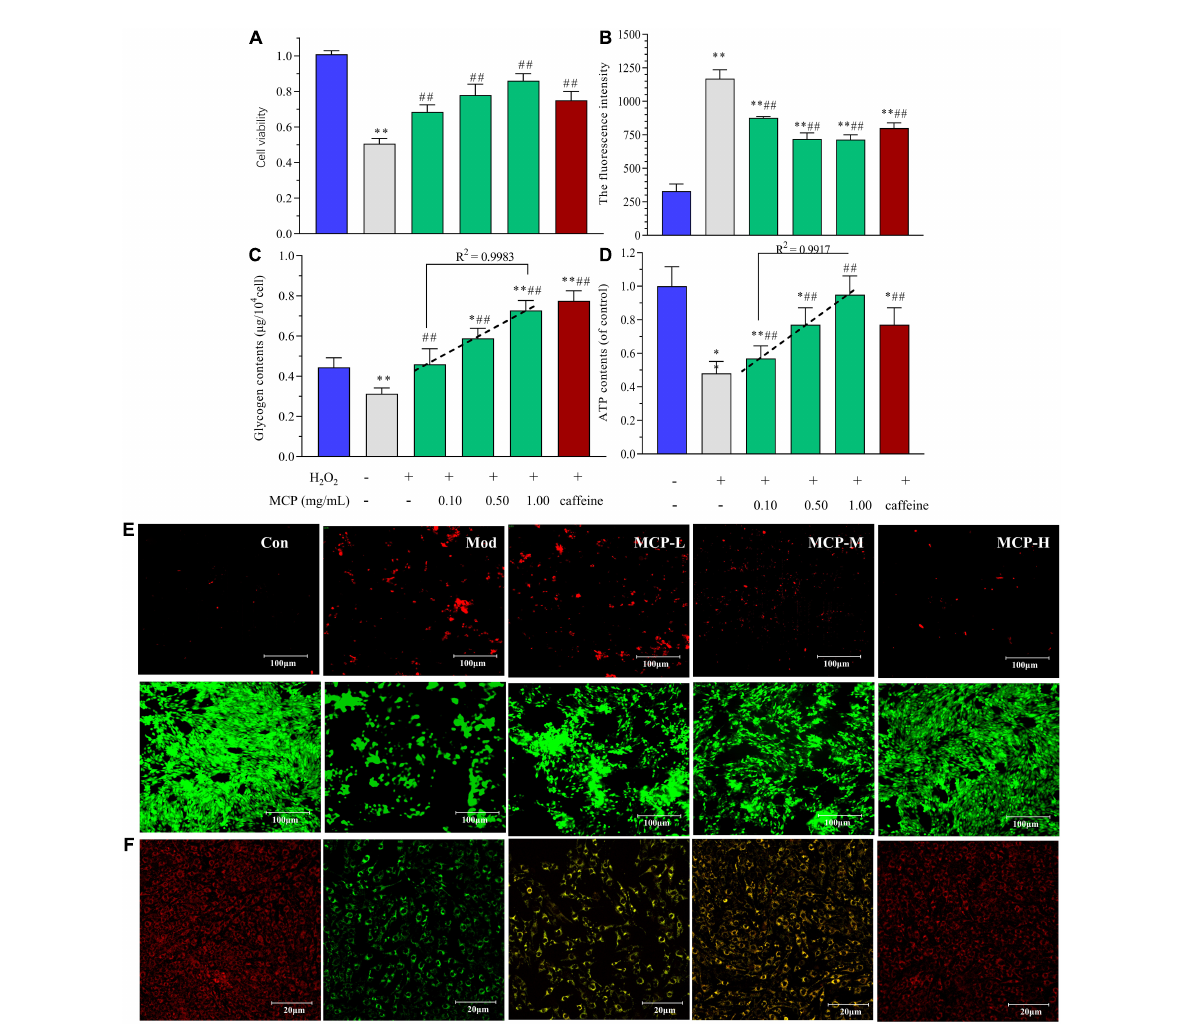
FIGURE6 Effects of Maca compound preparation (MCP) on H 2 O 2 -induced C2C12 cells. (A) Cell viability of MCP on oxidative stress-induced C2C12 cells. (B) ROS accumulation analyzed by flow cytometry. (C) Glycogen contents. (D) ATP generation capacity. The content of ATP was calculated as a value relative to that in con group, which was set as 100%. ∗ p < 0.05, ∗∗ p < 0.01 vs control (Con); # p < 0.05, ## p < 0.01 vs model (Mod). (E) The Live (green)/Dead (red) assay of C2C12 treated with H 2 O 2 -induced oxidative stress. (F) Mitochondrial membrane potential and morphology. MCP-L, MCP-M, MCP-H represent MCP of low, moderate, and high dose